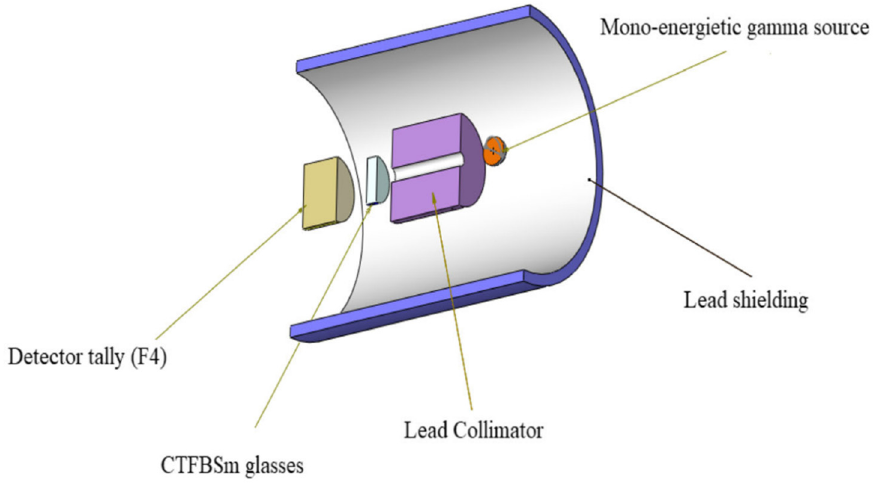
Figure 1. Schematic diagram with simulation geometry of the radiation shielding measurement.